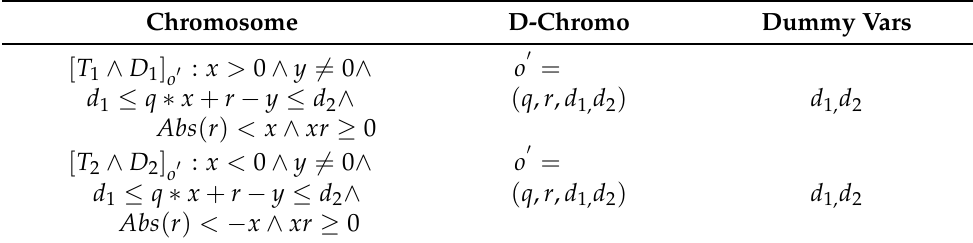
Table 1. Chromosome forms for functional scenarios of process Mod.